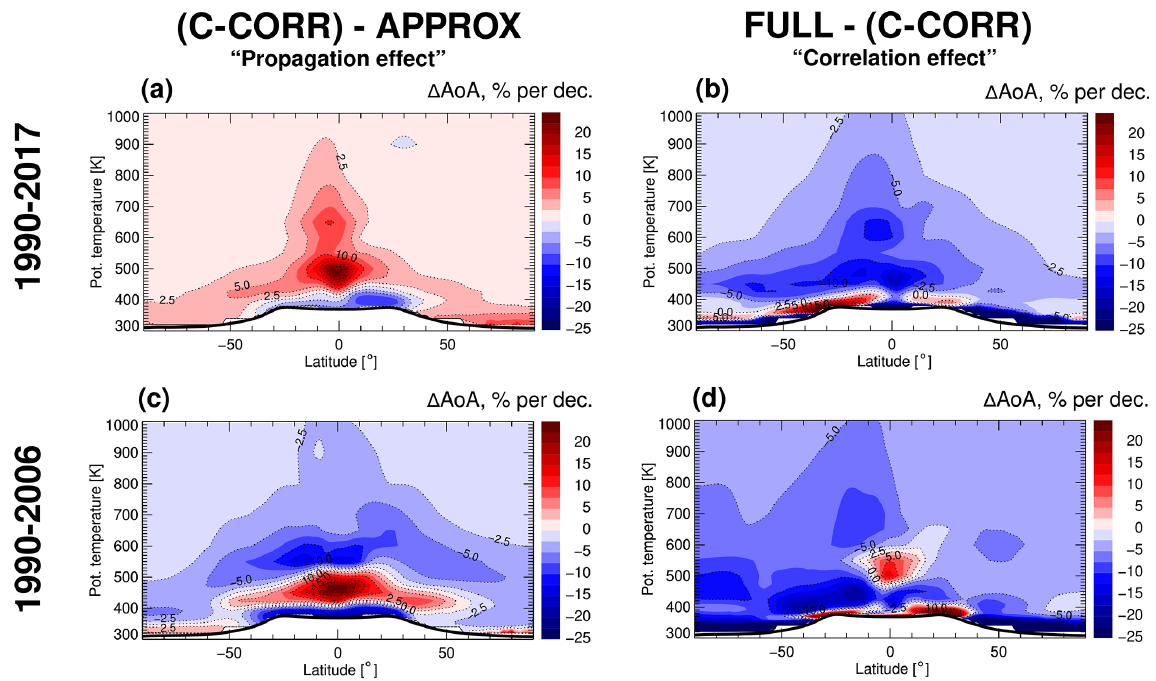
Figure 7. Differences in AoA trends during 1990–2006. Differences in AoA trends estimated with three methods, APPROX, C-CORR, and FULL, for the periods of 1990–2017 (a, b) and 1990–2006 (c, d) . The black line is the climatological tropopause calculated from ERA-Interim for the considered